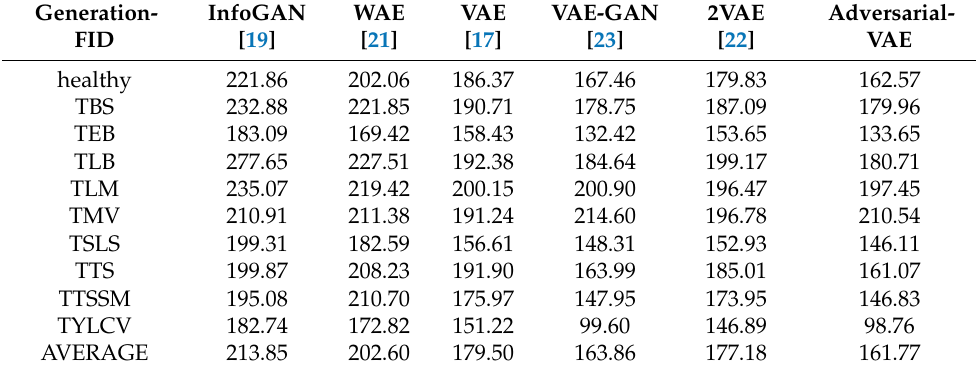
Table 6. Generation-FID comparison between different generative methods.